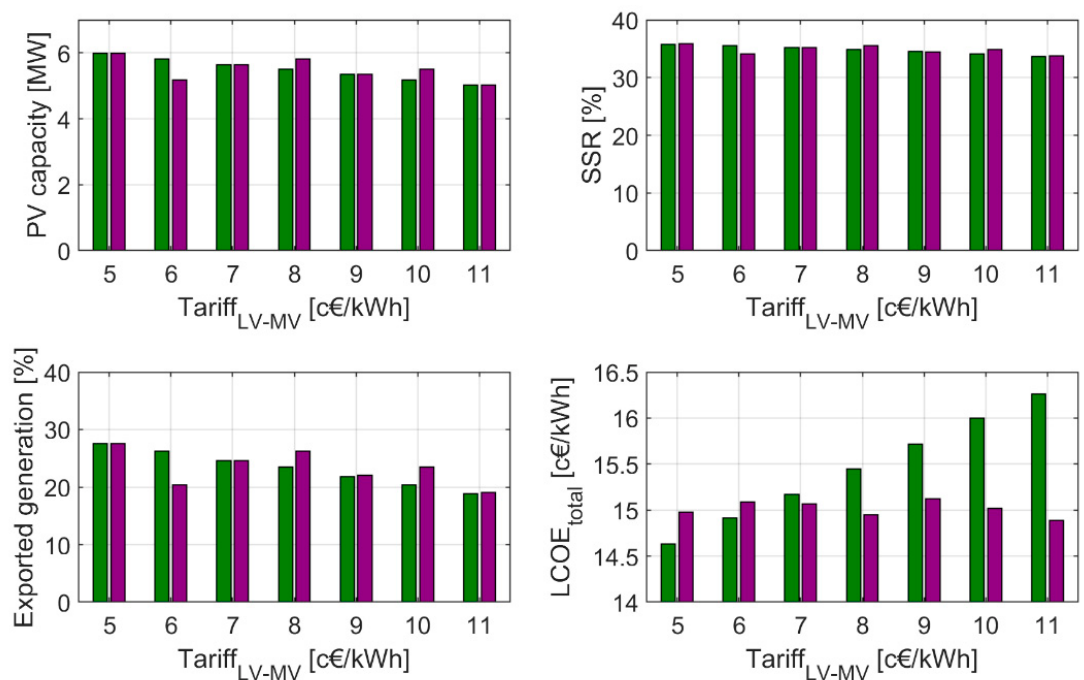
Figure 13. Comparing scenarios 3a (in green) and 3b (in purple) regarding the installed PV capacity (upper left plot), the achieved SSR (upper right plot), the percentage of exported PV generation (bottom left plot), and the LCOE total (bottom right plot).